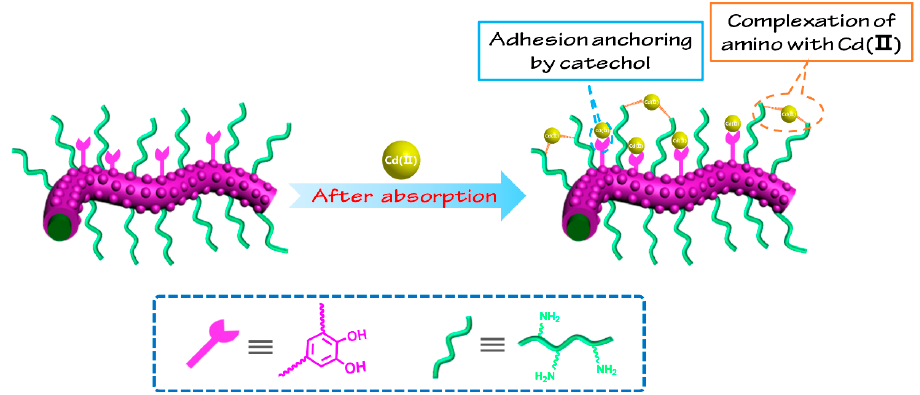
Figure 6. Schematic illustration of the proposed adsorption mechanism of Cd(II) ions by the SP-TAPI composites.